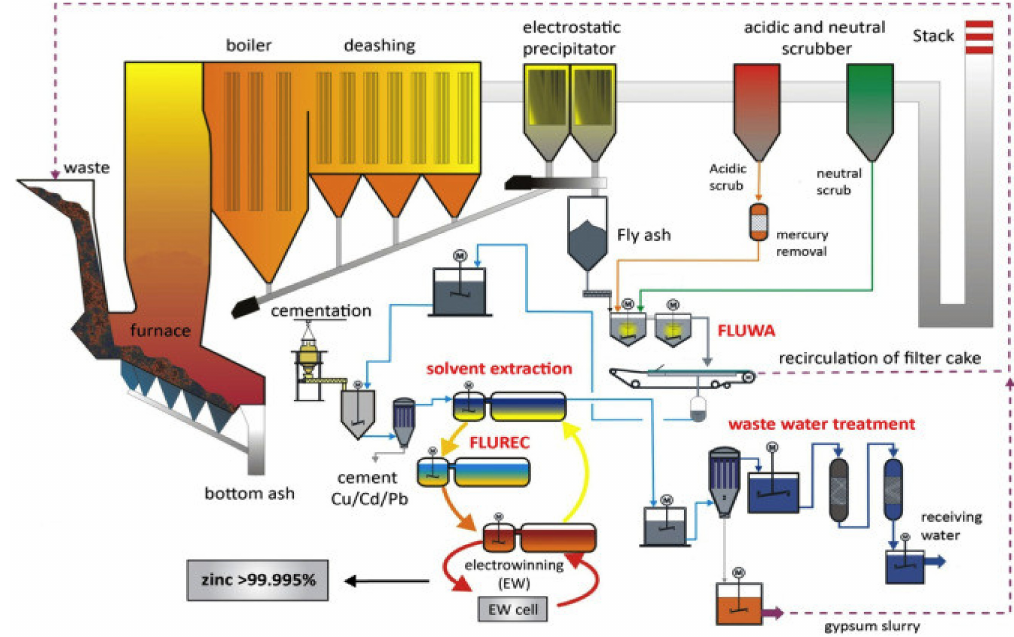
Figure 4. Process diagram of waste incineration, fly ash leaching (FLUWA) and recovery of recyclable materials (FLUREC).